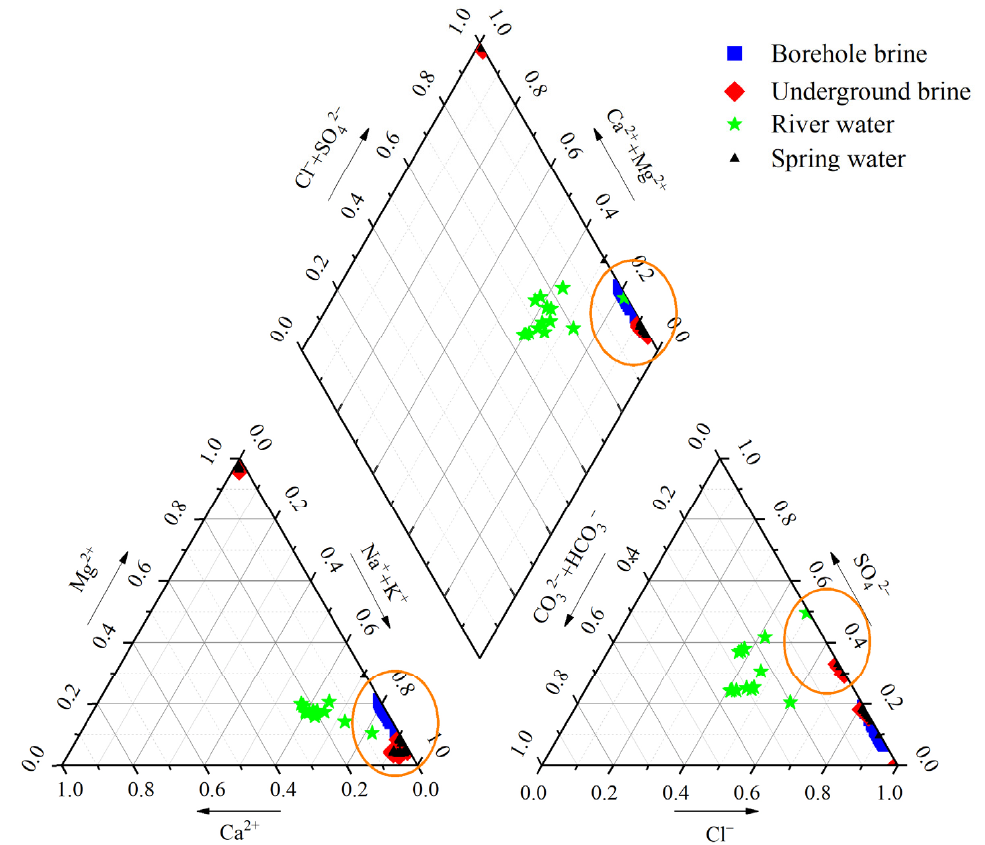
Figure 5. Piper triangle phase diagram of inflow waters of the Lop Nor Basin.